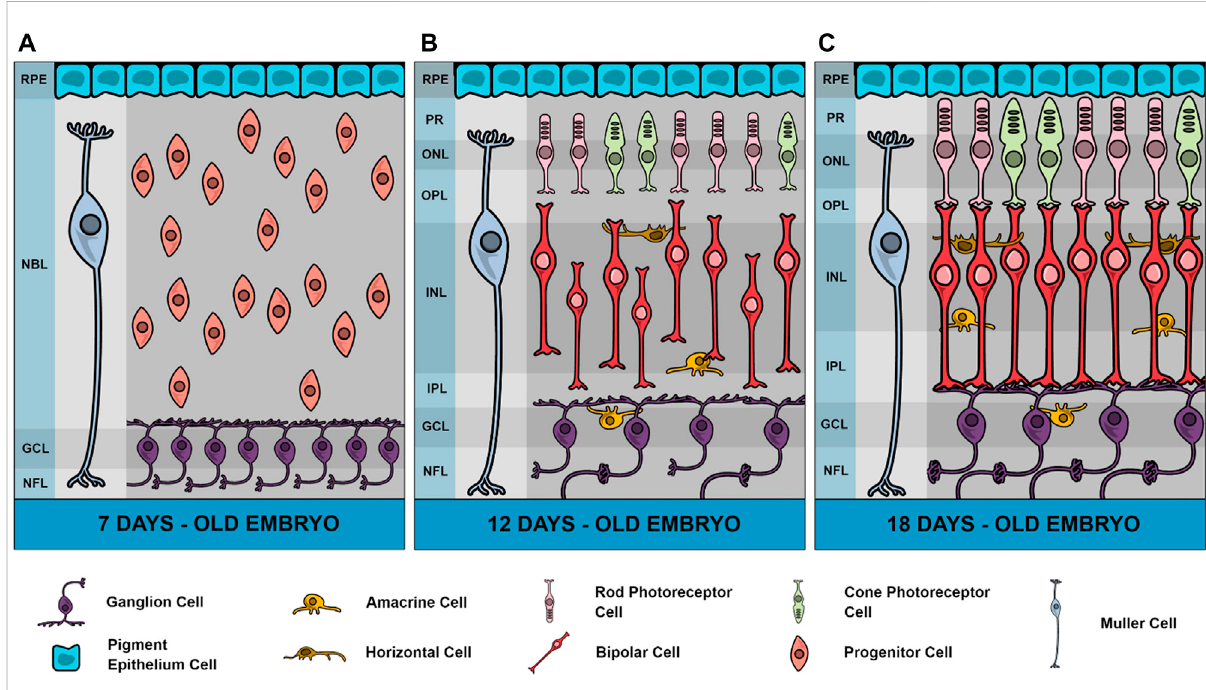
FIGURE 1 Schematic representation of chick retina in 3 different developmental stages. In embryonic day 7 (E7), neuroblasts are still dividing and a high number of ganglion cells are fully differentiated in a ganglion cell layer (GCL) and sending processes through a growing nerve fi ber layer (NFL). Plexiform layers are not yet de fi ned and instead is observed an extensive neuroblastic layer (NBL) and the retinal pigmented epithelium (RPE). Muller glial cells are also present in this stage. In E12 retinas, both inner and outer plexiform layers (IPL and OPL, respectively) are observed where neuronalprocessesprogressivelygrowbutsynapticcontactsareobservedonlyafterE13inIPL.Amacrinecellscanbeobservedinbothinnernuclear layer (INL) and GCL (displaced amacrine cells) and horizontal cells in the external limit of INL. From E12 to E18 there is a progressive increase of IPL and OPL thickness. Photoreceptors present a late development in the chick retina with the external segment (PR) beginning to grow in E15 and synapses between photoreceptors and bipolar cells appearing only in E17. In E19, the retina can be considered mature, and the fi rst light responses areobserved.VariationsinthicknessofretinallayersweredrawnaccordingtoZareenetal.(2010),buttotalretinathicknessindifferentstagesarenot represented in this fi